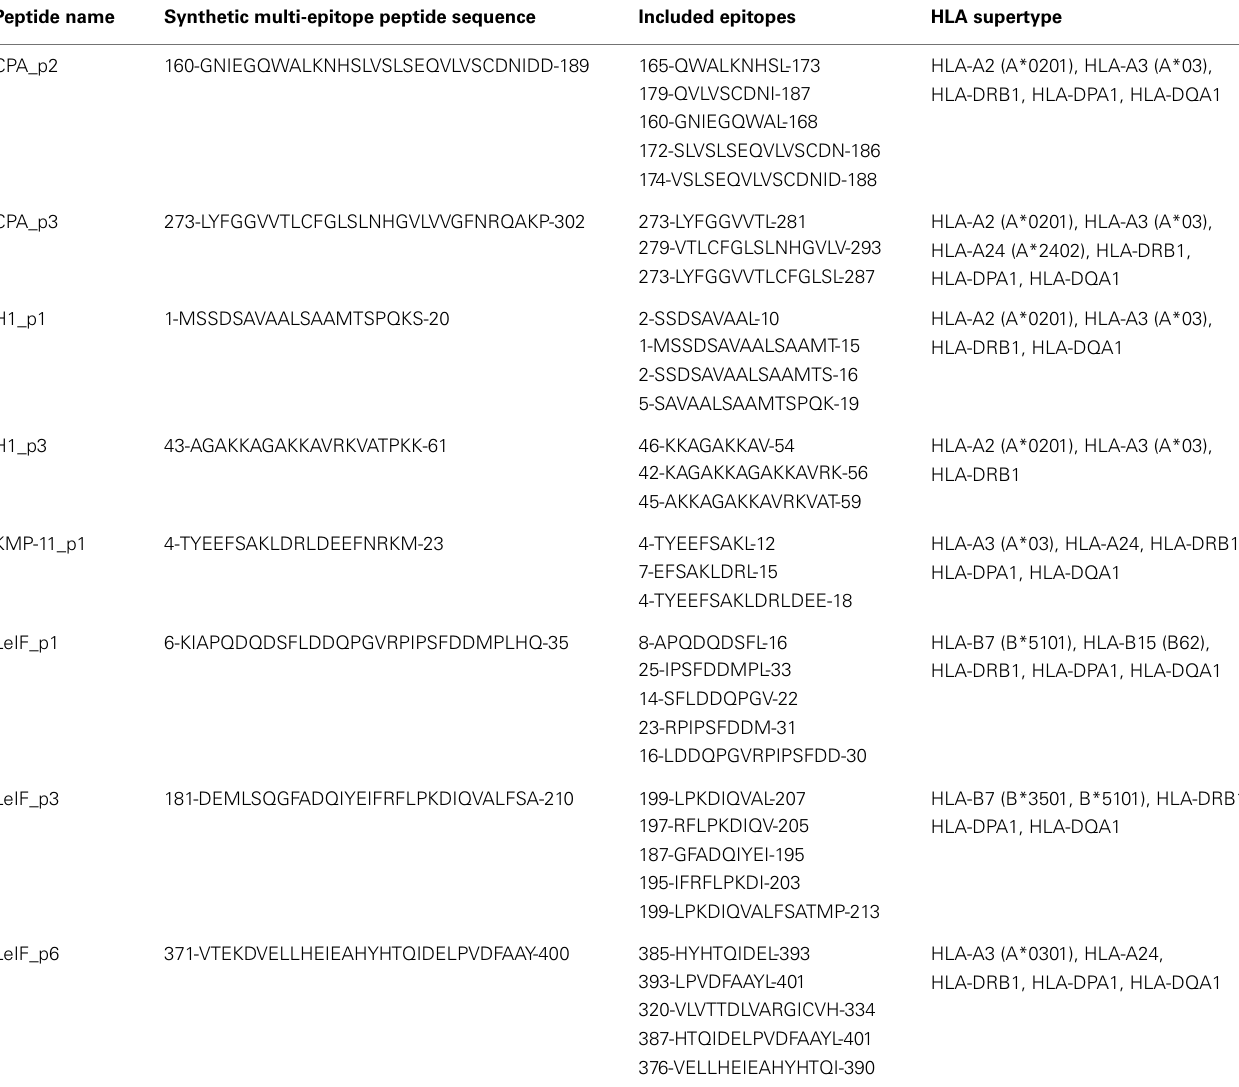
Table 4 | Synthetic multi-epitope peptides including MHC class I and II-restricted epitopes